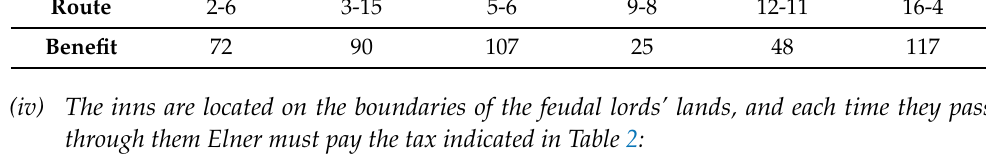
Table 1. Benefit in points for transporting a package between two directly connected crossroads i and j , represented as i − j . Route